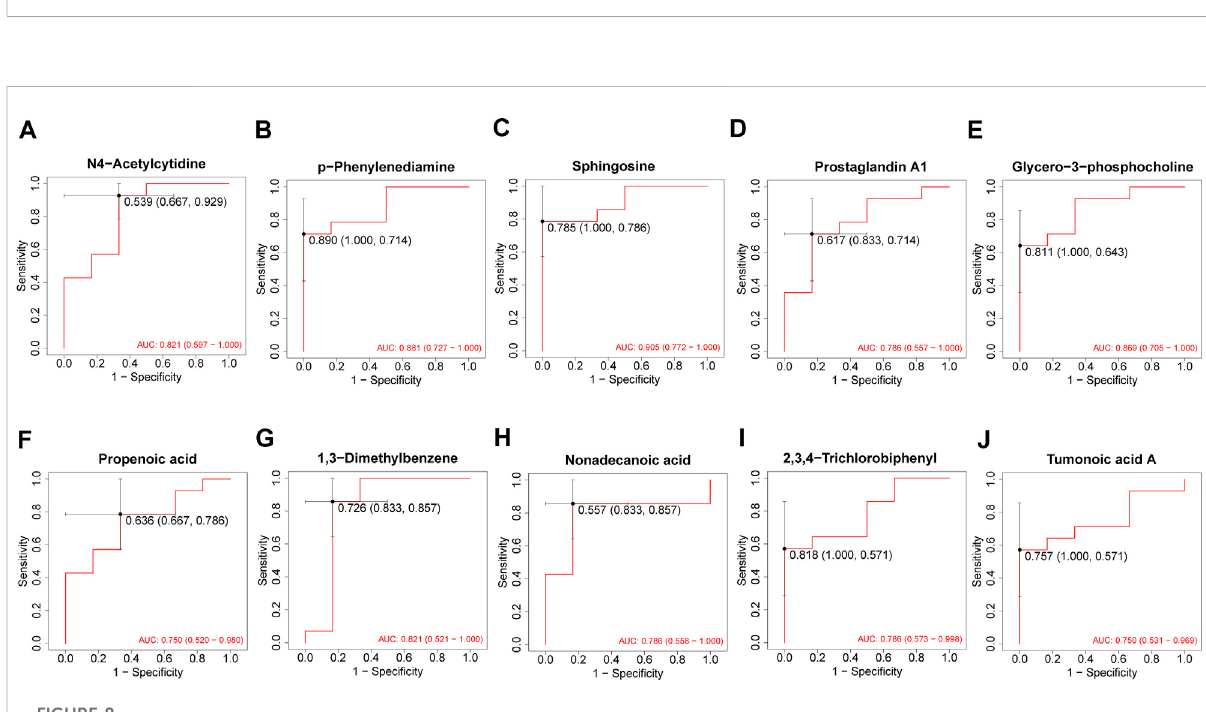
FIGURE 8 ROC analysis of top 10 most discriminant metabolites (A – J) for predicting a hearing recovery in SSNHL patients. ROC: receiver operating characteristics; SSNHL, sudden sensorineural hearing